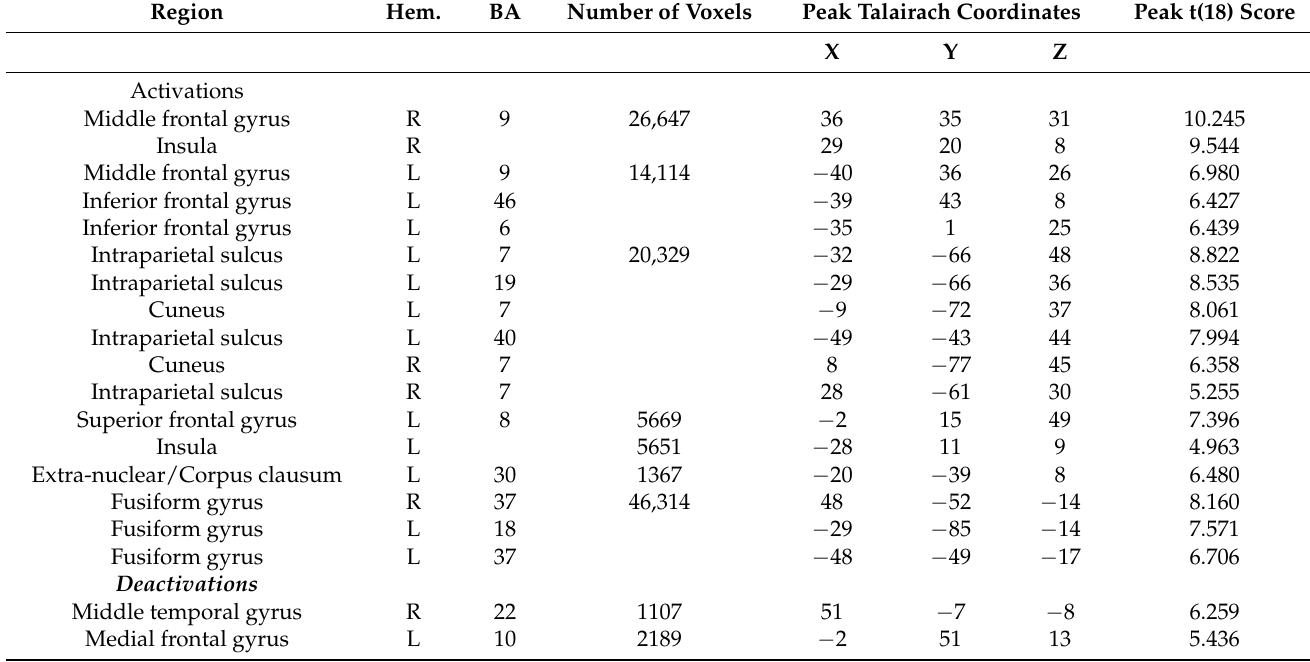
Table 1. Brain areas that showed significant engagement in approximate calculation